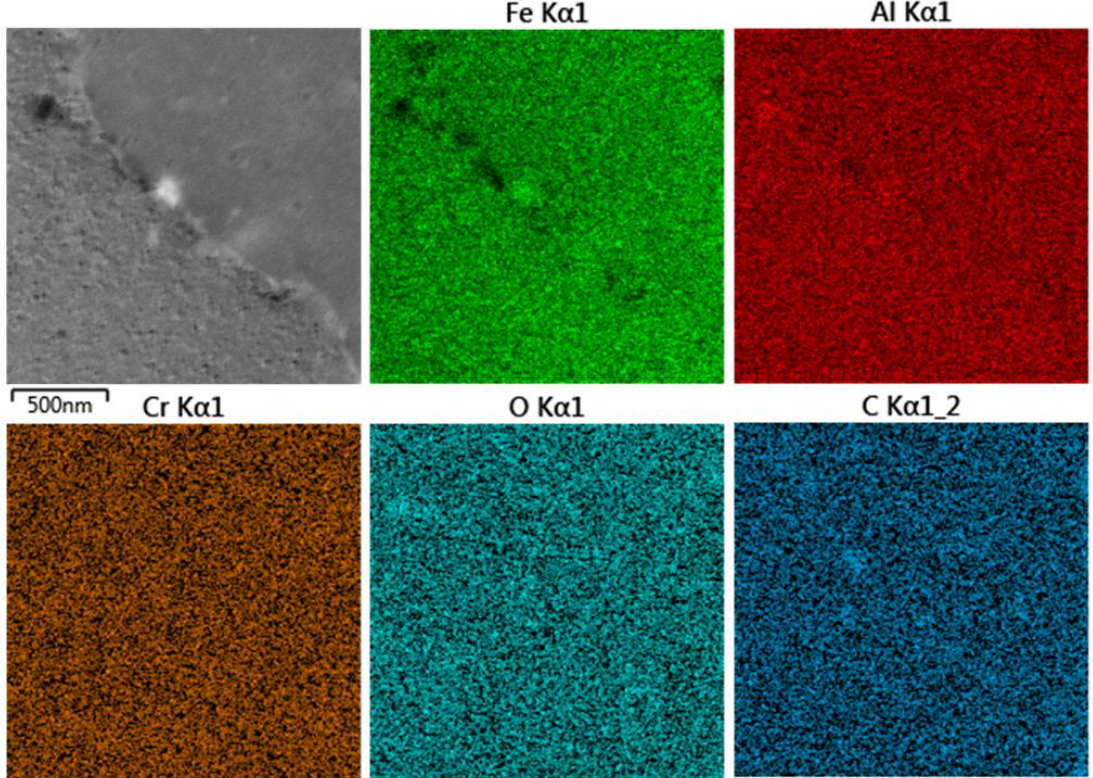
Figure 10. STEM / BF detailed micrographs and EDS elemental maps of Fe28Al SPS compacted at Figure 10. STEM/BF detailed micrographs and EDS elemental maps of Fe28Al SPS compacted at 1100 1100 ◦ C sintered from 1-h milled °C sintered from 1-h milled powder.